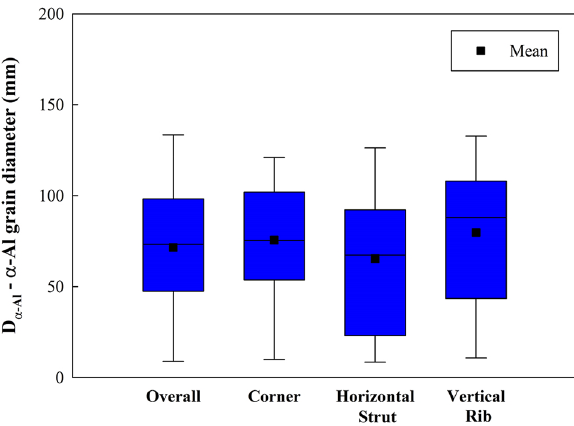
Figure 7. α-Al grain diameter in different fields (n = 50).